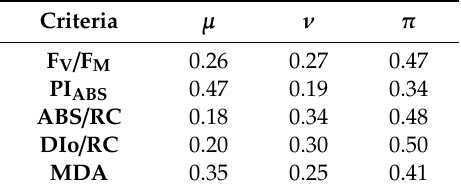
Table 11. Weighted aggregated IF decision matrix for criteria of cold subcategories.